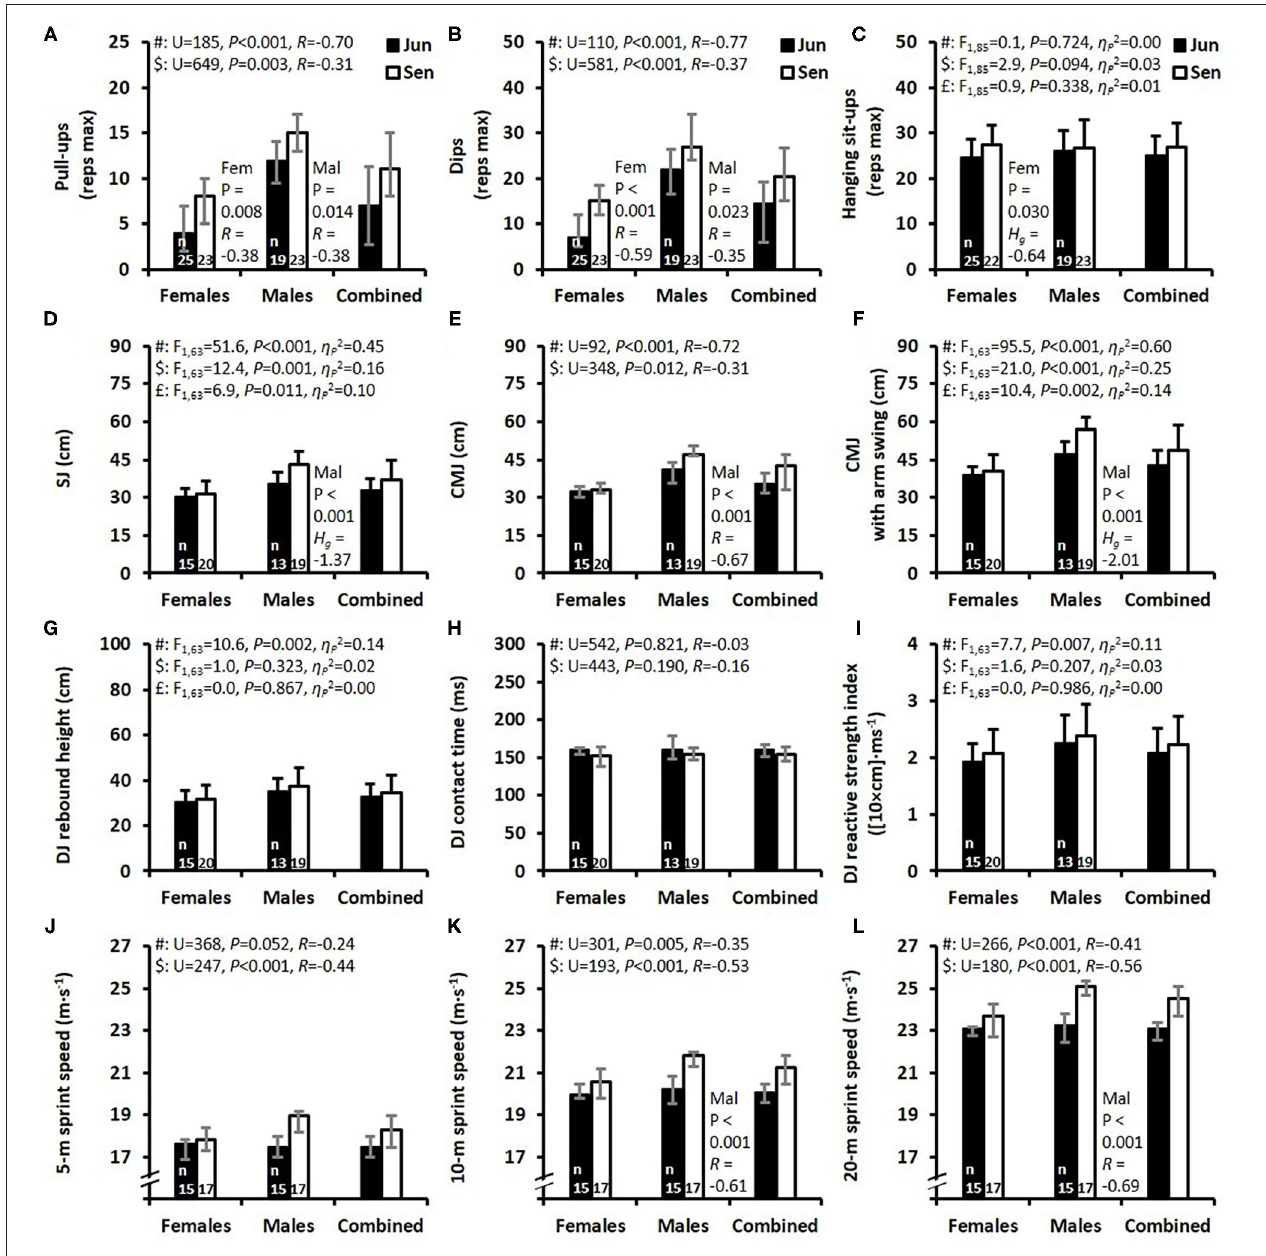
FIGURE 2 | Results for the strength (A–C) , jumping (D–I) , and running sprint (J-L) performances presented as mean ± SD (C,D,F,G,I) and as median and interquartile range (A,B,E,H,J–L) for the junior (Jun) and senior (Sen) female and male athletes and the combined group of female and male athletes. Abbreviations: SJ, squat jump; CMJ, countermovement jump; DJ, drop jump; reps max, the maximum number of repetitions; Fem, females; Mal, males; Hg, Hedges’ g effect size. F-values, P-values, and partial eta squared effect size ( η 2 p ), were obtained by a two-way ANOVA. #Main effect of sex. $Main effect of age group. £Main effect for interaction between sex and age group. In case of a significant interaction effect, a within-sex-group comparison of Jun vs. Sen was performed with an independent t -test (D,F) with significant results being reported. In (A,B,E,H,J–L) , P -values were obtained with a Mann-Whitney U-test presented together with an R effect size, and separate within-sex-group comparisons between juniors and seniors were performed using a Mann-Whitney U -test with significant results being reported. The numbers located at the bottom of each of the four bars indicate the number of participants ( n ) in the specific test.